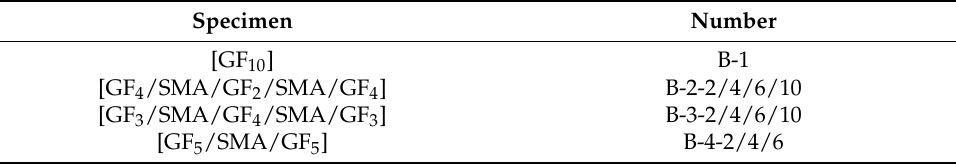
Figure 3. The structural arrangement of SMAHC laminates. Table 2. Tensile and bending test specimens.